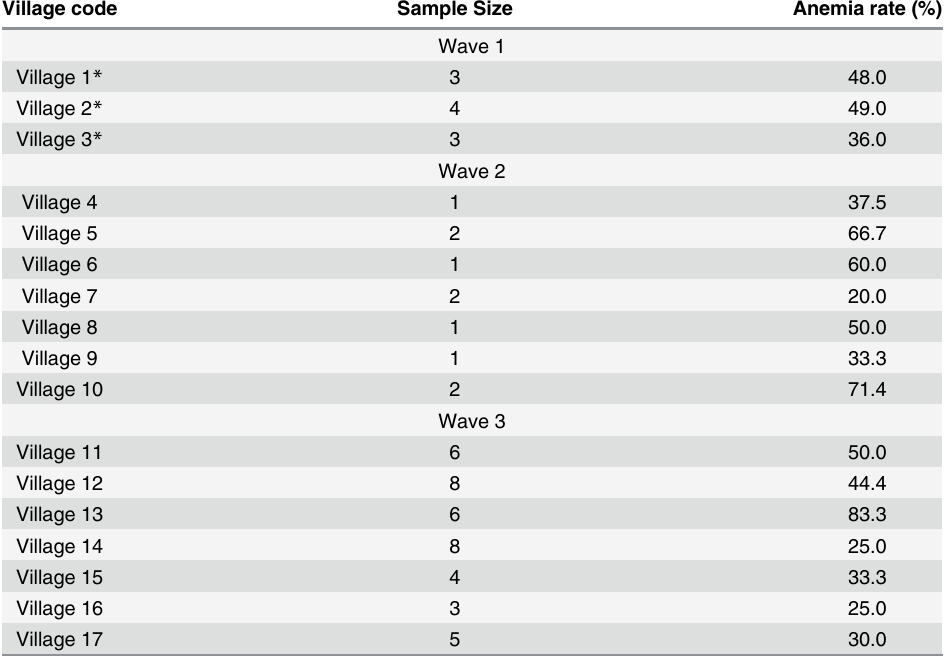
Table 2. Anemia rate by village in rural Shaanxi Province,